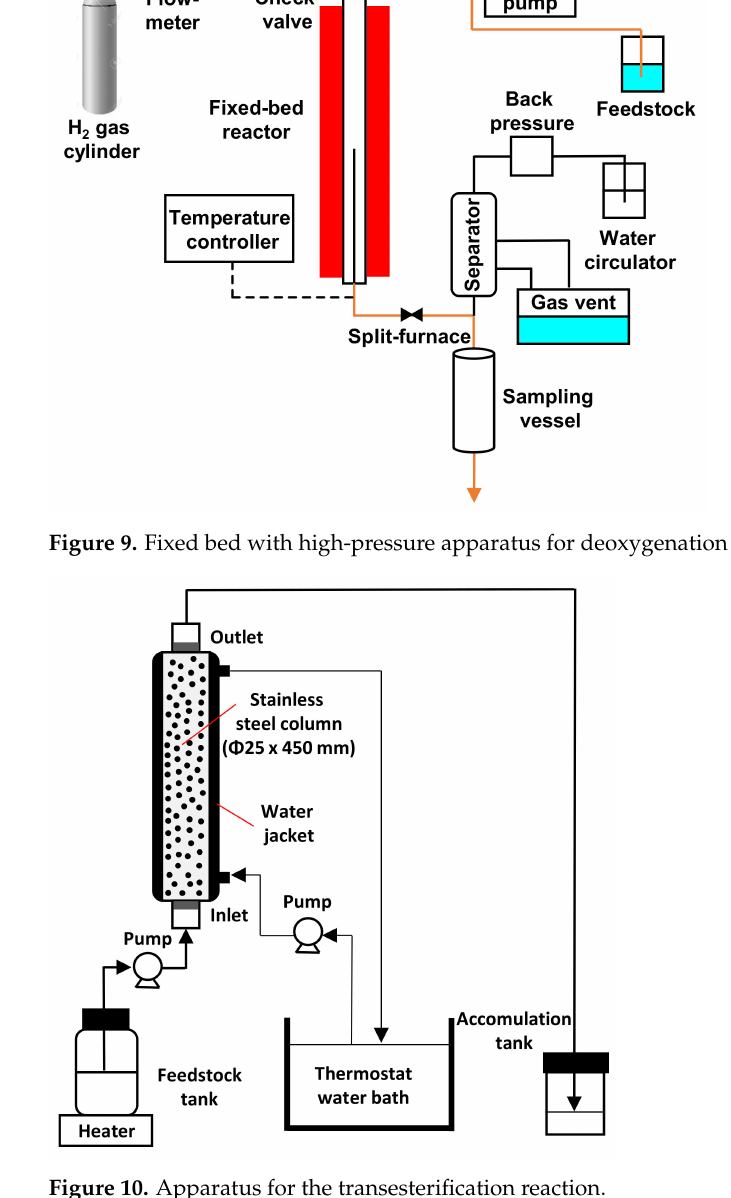
Figure 10. Apparatus for the transesterification reaction.